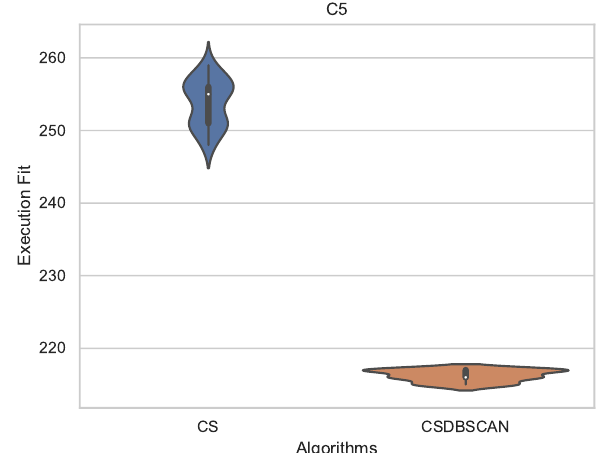
Figure 9. Instance C.5 distribution.